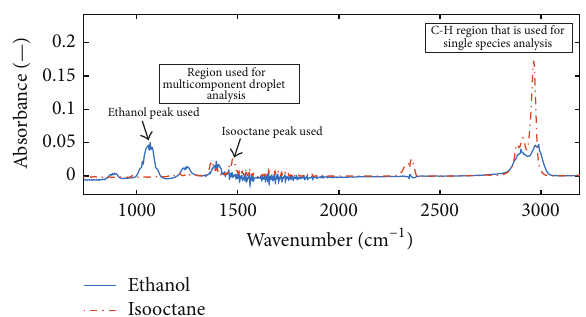
Figure 2: Spectra of isooctane and ethanol from this study where the absorbance peaks used to track composition are